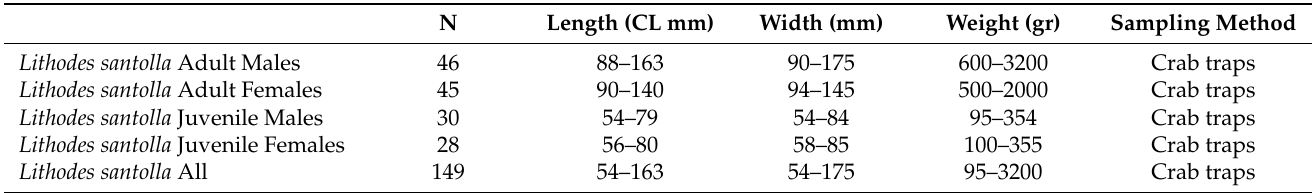
Table 1. Size and weight ranges of Lithodes santolla by maturity stage and sex. Sample size and sampling method of southern king crab collected in Nassau Bay, Cape Horn.